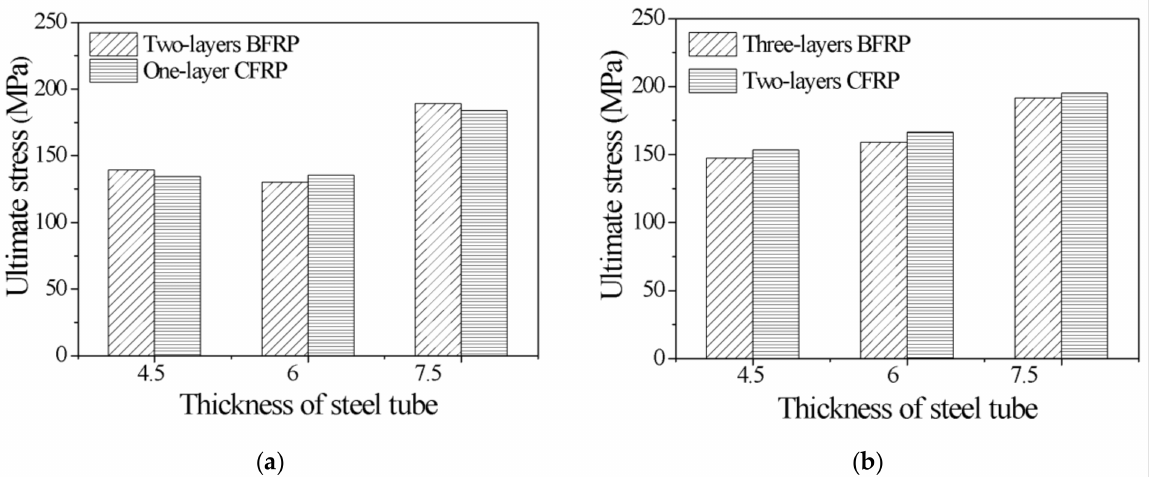
Figure 10. Effect of the FRP type on the ultimate stress. ( a ) Two-layers BFRP and one-layer CFRP. ( b ) Three-layers BFRP and two-layers CFRP.